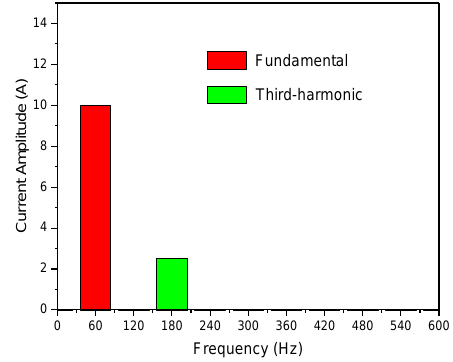
Figure 4. FFT plot for phase A of the armature currents.